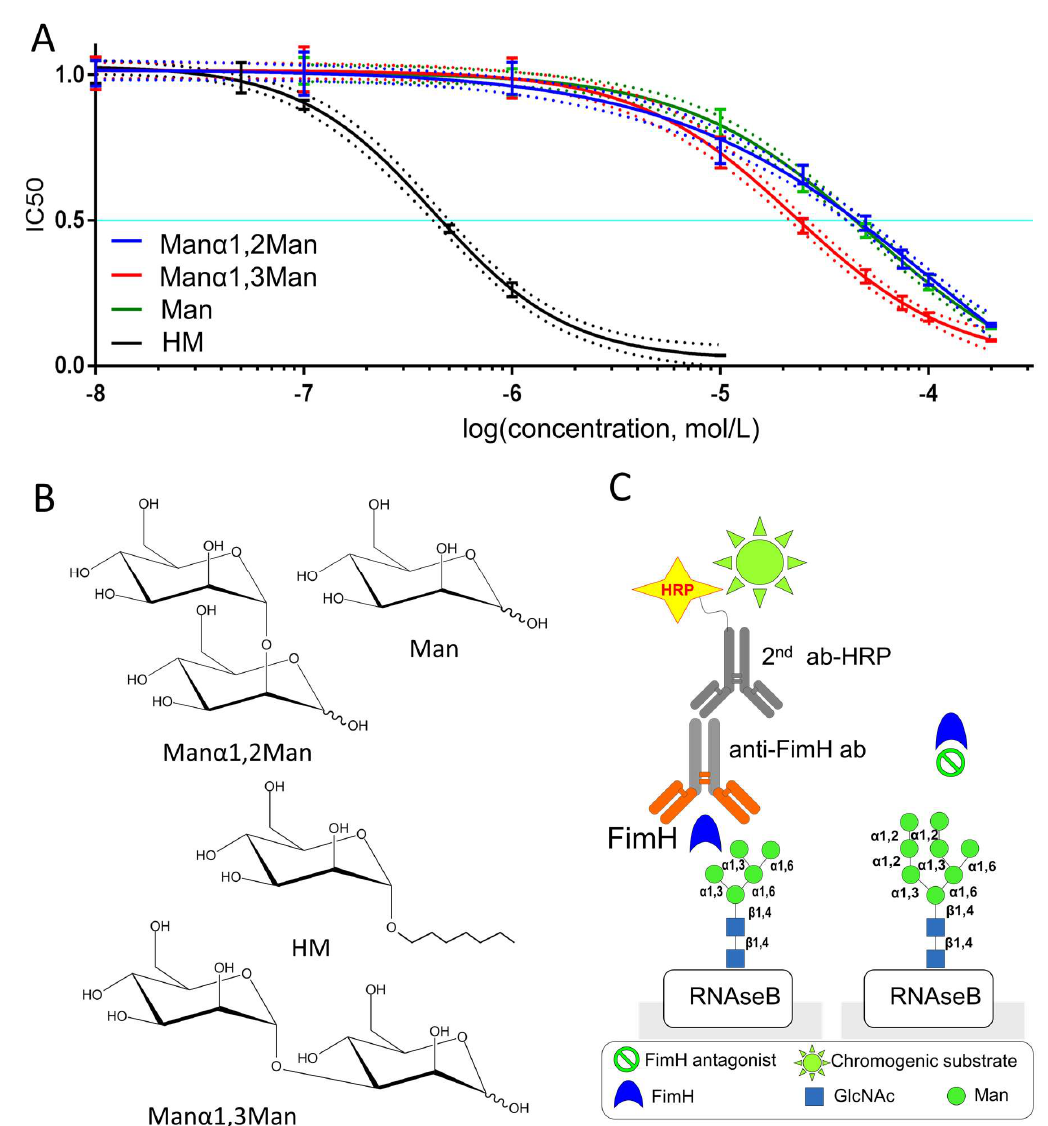
Figure 1. IC 50 measurements of different mannosides towards their ability to block FimH interaction with oligomannose glycoepitopes using ELLSA assay. ( A ) Interaction of FimH with oligomannose glycoepitopes depends on mannoside concentration. The chemical structures of the tested mannosides are shown in ( B , C ) In ELLSA, the high-mannose N -glycan on RNAseB (shown are oligomannose-5 (left) and oligomannose-8 (right)) is used as target for FimH lectin binding [26,27]. The latter is detected by incubation with anti-FimH antibodies (Anti-FimH ab) and secondary horseradish peroxidase HRP-conjugated antibodies (2nd ab-HRP). Horseradish peroxidase activity is visualized by chromogenic substrate (TMB, 3,3’,5,5’-tetramethylbenzidine). The concentration of inhibitor needed to inhibit 50% of FimH binding to RNAseB corresponds to the IC 50 .